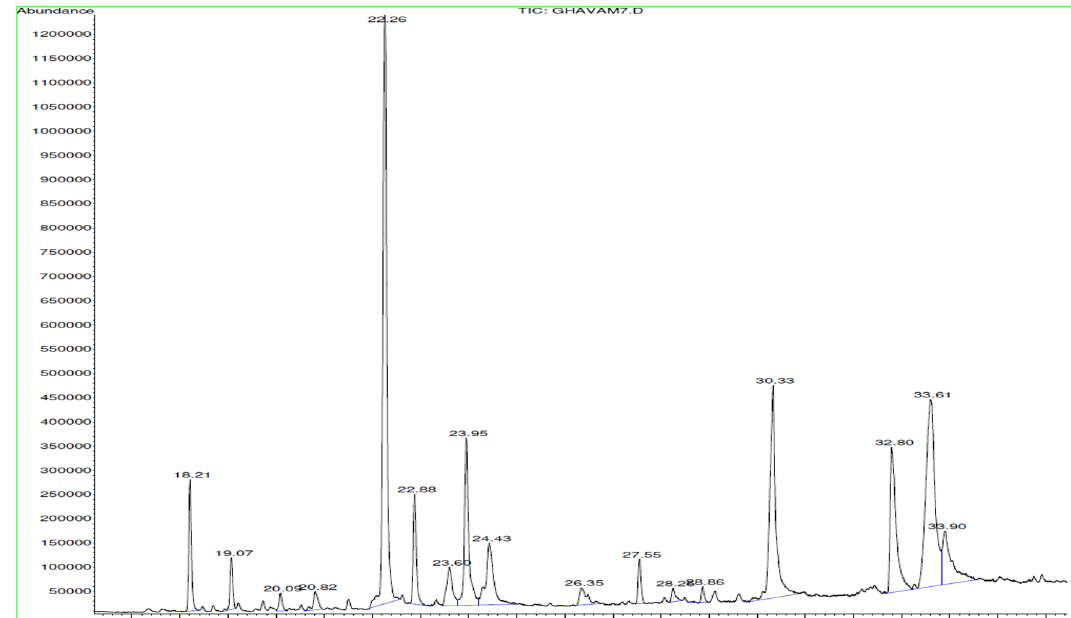
Figure 3. GC–MS chromatogram of essential oil obtained from Hymenocrater incanus.